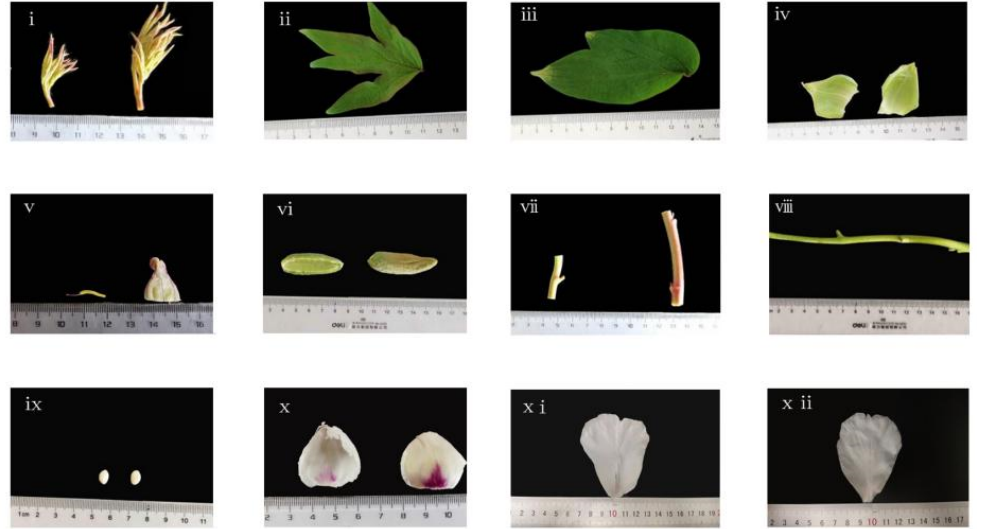
Figure 1. Different organs of the tree peony. ( i ) Young leaf; ( ii ) mature leaf; ( iii ) old leaf; ( iv ) calyx; ( v ) stamen and ovary; ( vi ) pod skin (30 d); ( vii ) young stem and mature stem; ( viii ) old stem; ( ix ) seeds (30 d); ( x ) young petal; ( xi ) mature petal; ( xii ) old petal. Samples of mature leaves were treated with 10% PEG-8000, 100 mmol/L NaCl, 100 μ mol/L ABA, and 150 μ mol/L GA 3 for 0 h, 1 h, 3 h, 6 h, 12 h, 24 h, and 48 h, and three